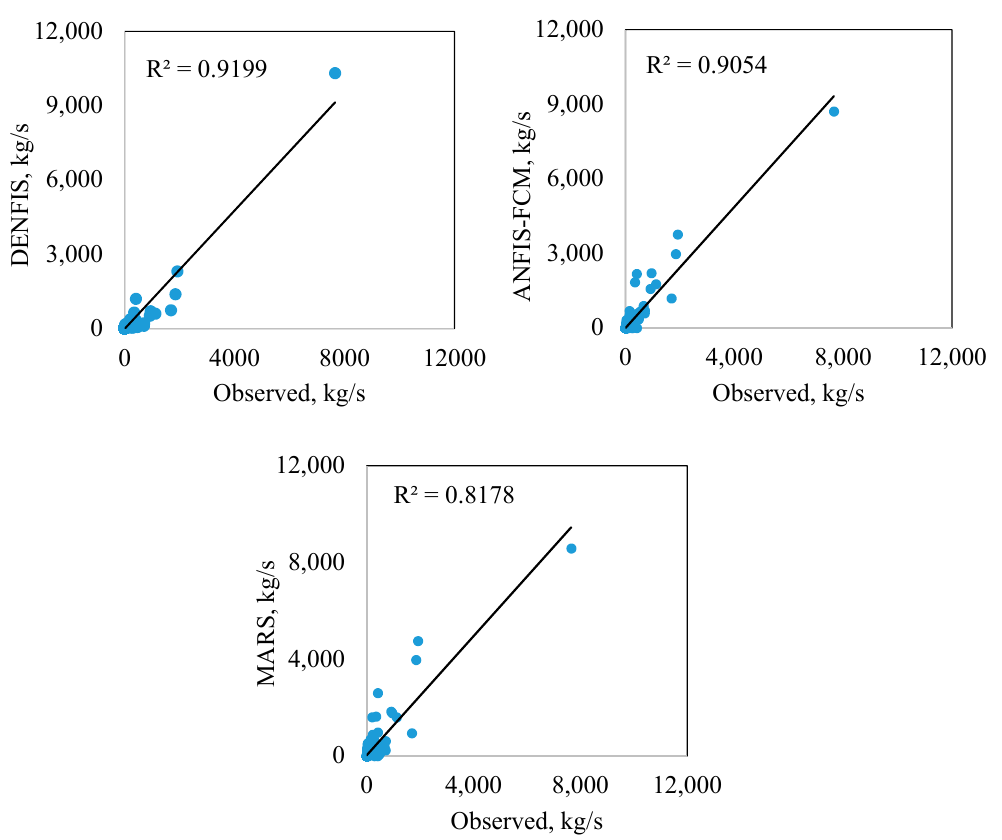
Figure 6. Time scatterplots of the observed and estimated suspended sediment by DENFIS, ANFIS-FCM and MARS in the test period at Guangyuan Station.